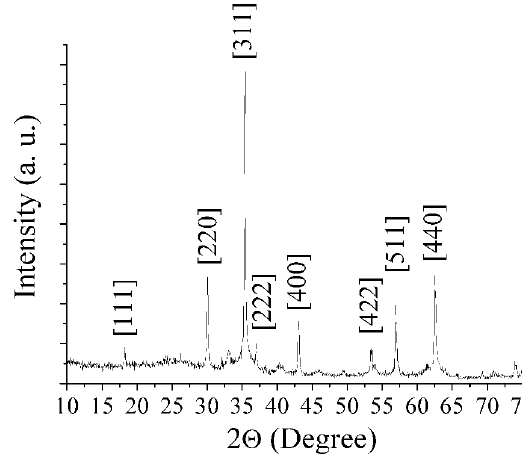
O @C nanoparticles. 3 4